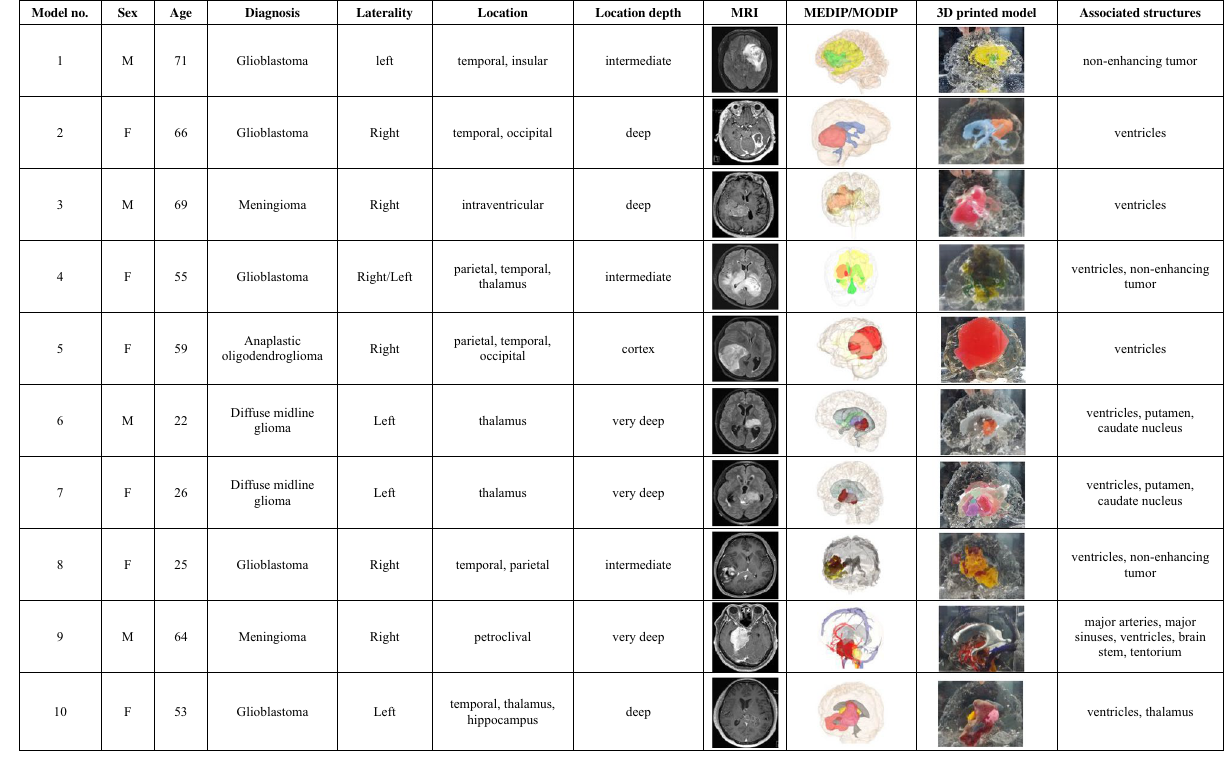
Table 1. Clinical features of 10 fabricated 3D printed brain tumor models. M, male; F, female; MRI, magnetic resonance image; 3D,